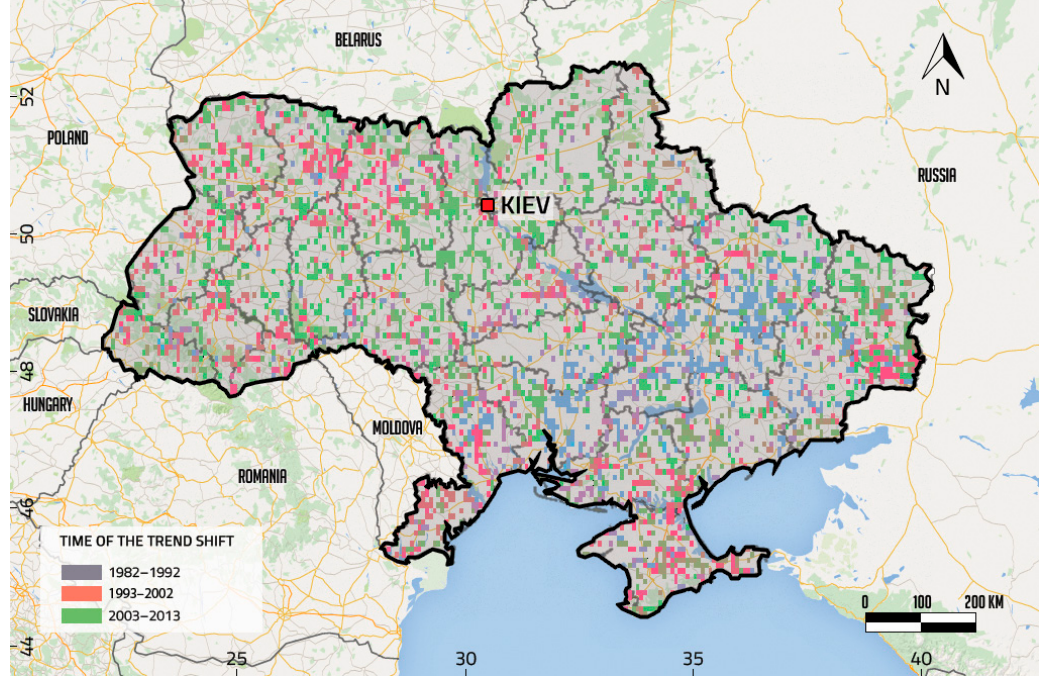
Figure 4. Spatial distribution of the time of the shift classified in three major time intervals.